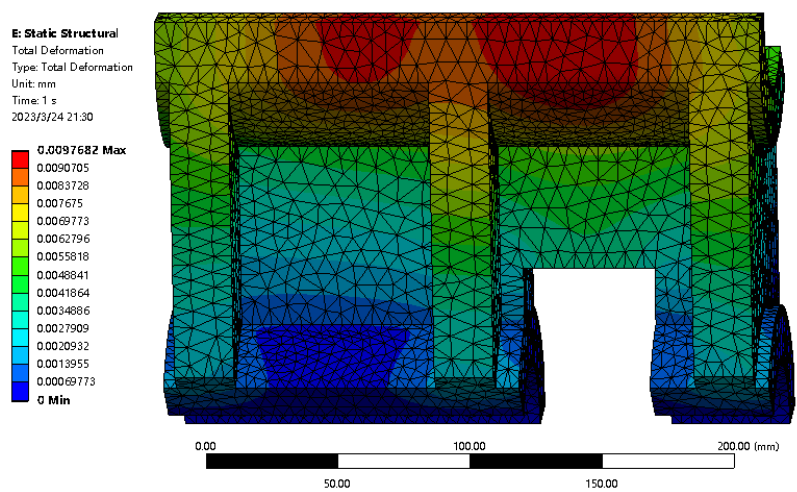
Figure 30. Deformation result.